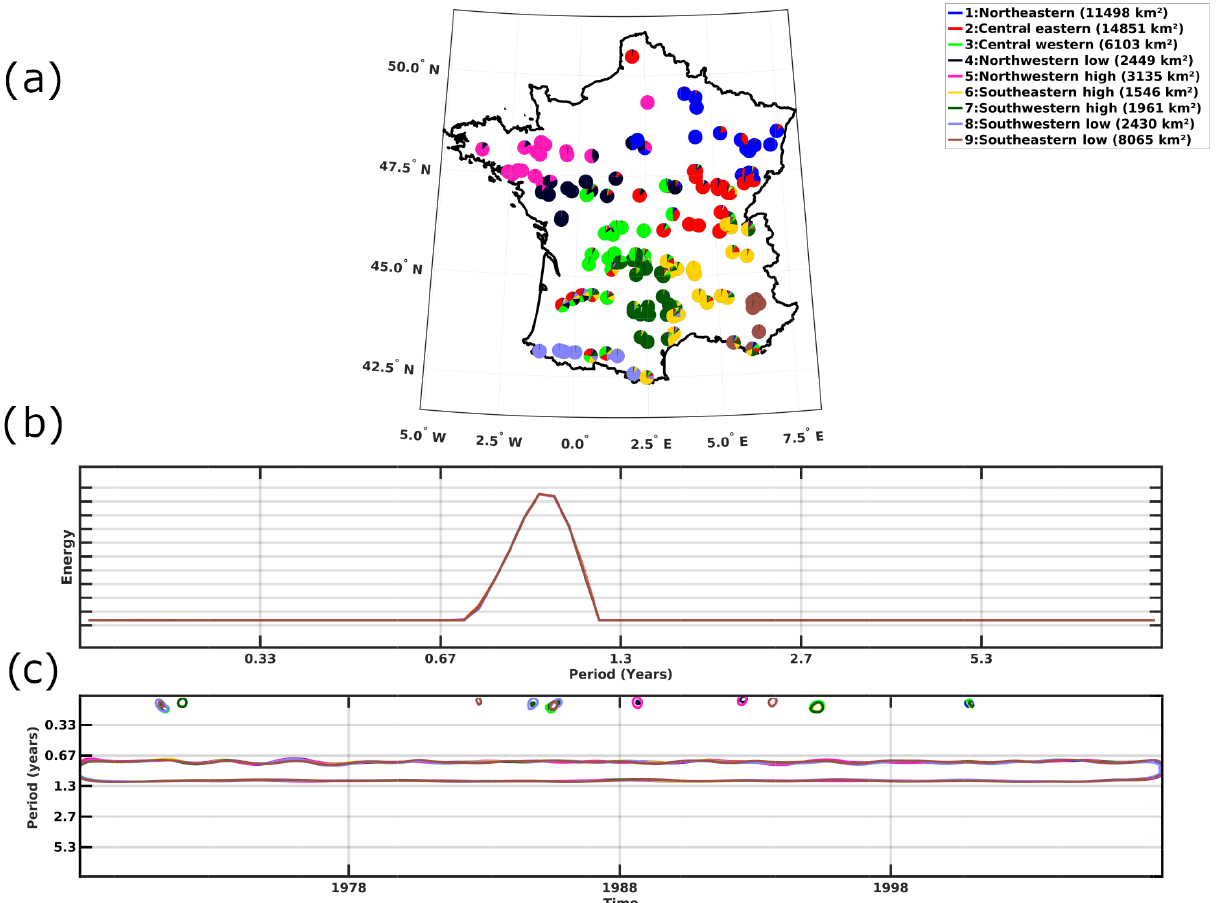
Figure 7. Clustering of temperature time frequency variability in France. (a) Classification map of the watersheds. Pie chart slices show the three highest probability memberships. (b) Global wavelet spectra of regions. (c) Wavelet spectra of homogeneous regions. For clarity, only timescales and time locations that are 95% statistically significant and with the largest variability are shown (colored